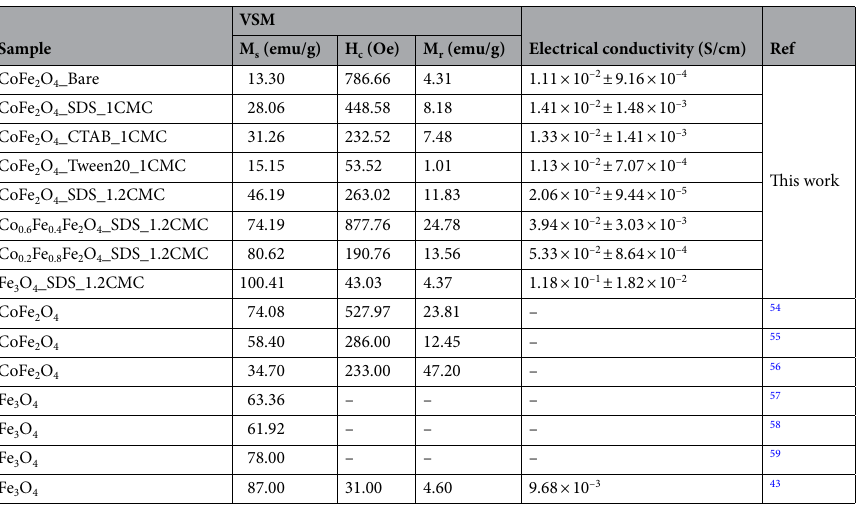
Table 2. Magnetic and electrical properties of Co x Fe 1−x Fe 2 O 4